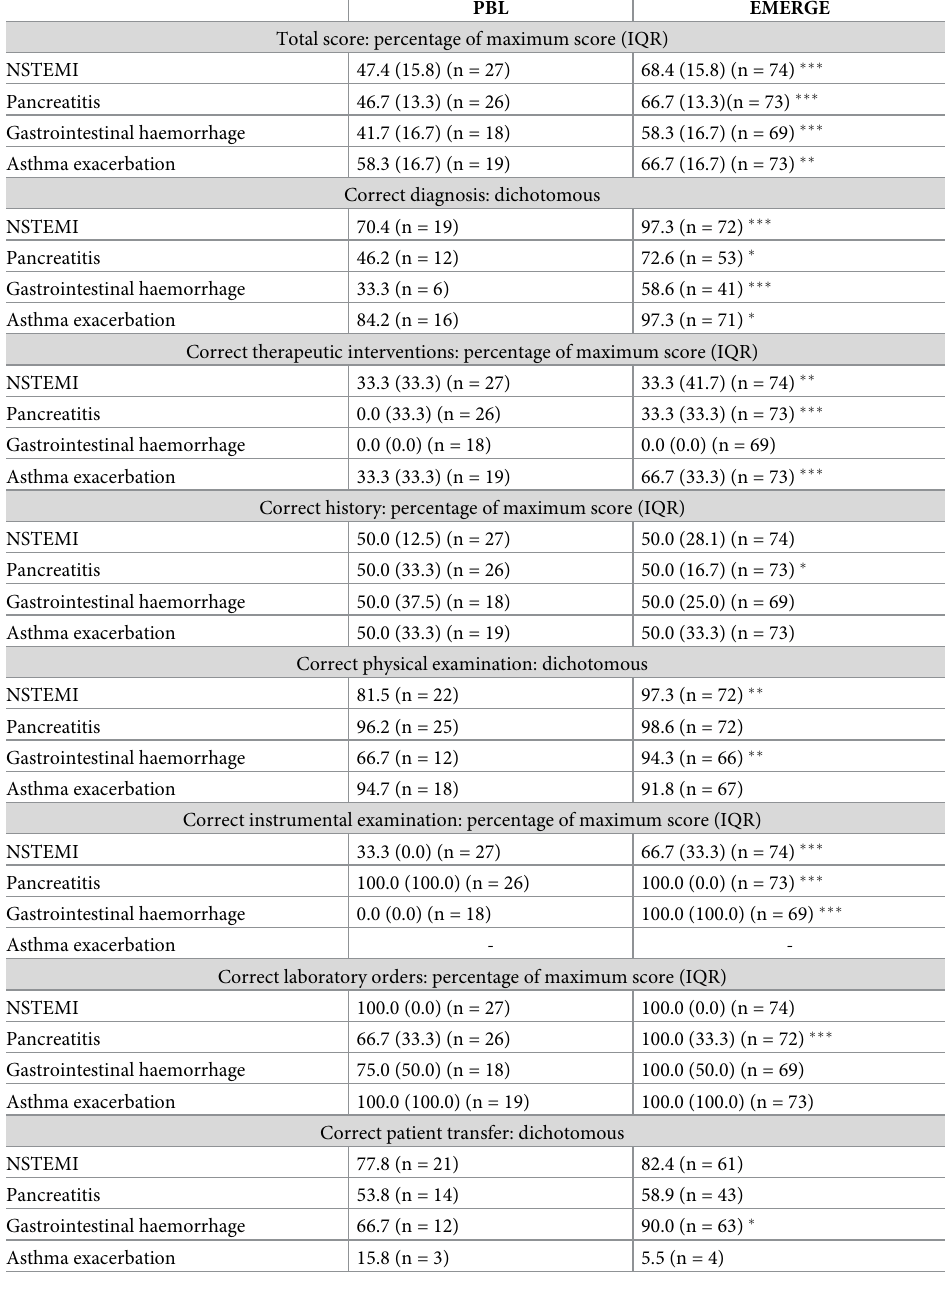
Table 3. Student performance in the final EMERGE